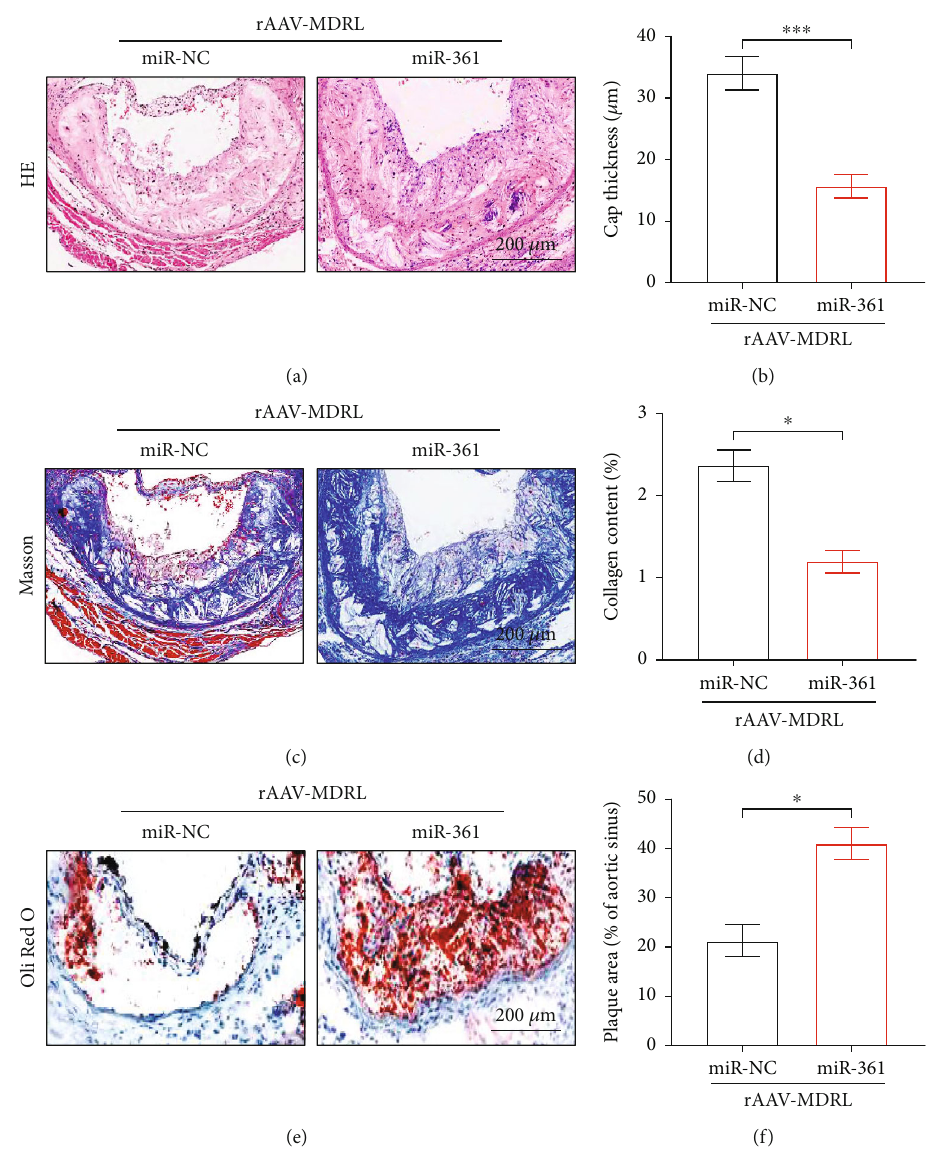
Figure 7: Overexpression of miR-361 counteracts the protective e ff ect of MDRL against atherosclerosis. (a) Representative images of HE- stained aortic roots from control miRNA (miR-NC) or miR-361-treated LDLR -/- mice after intravenous injection of rAAV-MDRL. (b) Quanti fi cation of fi brous cap thickness. (c) Representative images of Masson-stained aortic roots from miR-NC or miR-361-treated LDLR -/- mice. (d) Quanti fi cation of collagen content. (e) Representative images of Oil red O-stained aortic roots from miR-NC or miR- 361-treated LDLR -/- mice. (f) Quanti fi cation of plaque area. Scale bar: 200 μ m. Data are presented as mean ± SEM. ∗ P < 0 : 05 vs miR-NC